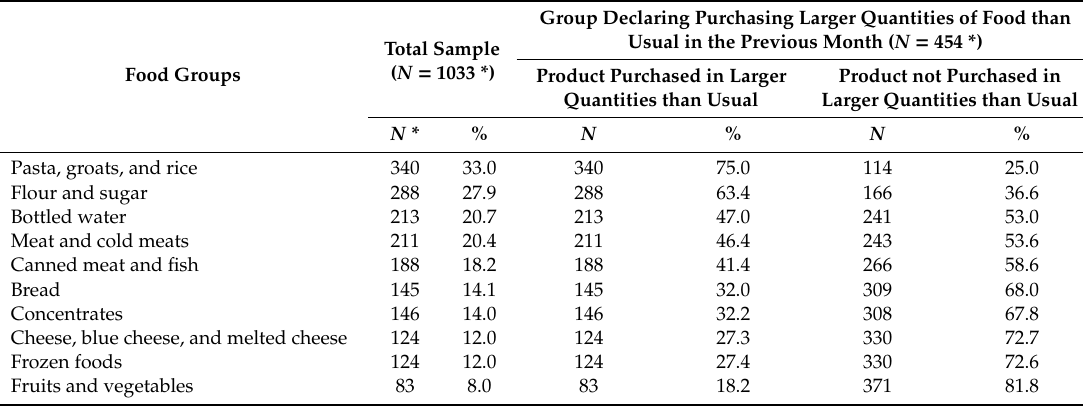
Table 5. Foods purchased in larger quantities during the COVID-19 pandemic.